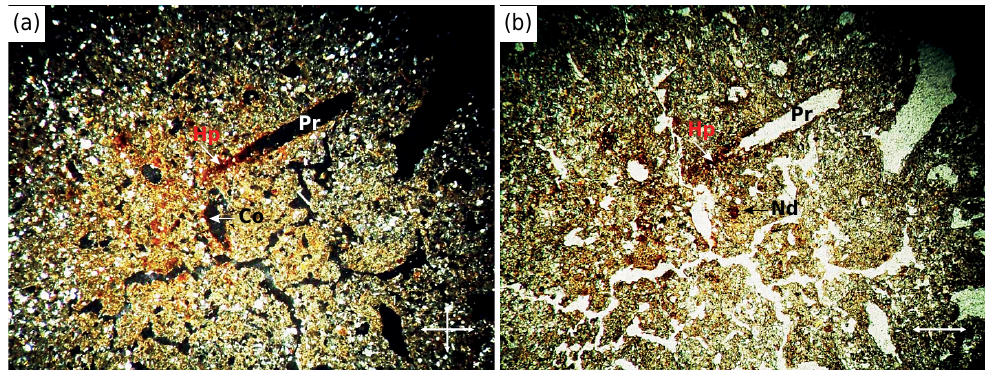
Figure 4. Photomicrographs images of 2Btvnz horizon in the Planosol profile [(a): cross-polarized light; (b): natural light]. Presence of pores (Pr) and features of coating (Co), hypo-coating (Hp), and typical nodule (nd).